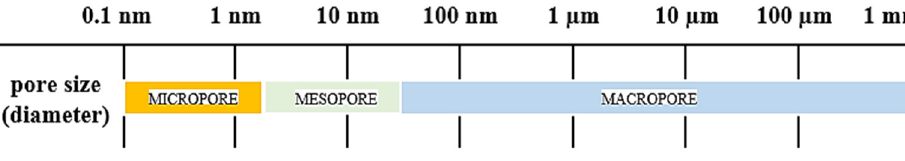
Figure 1. Pore size classification.